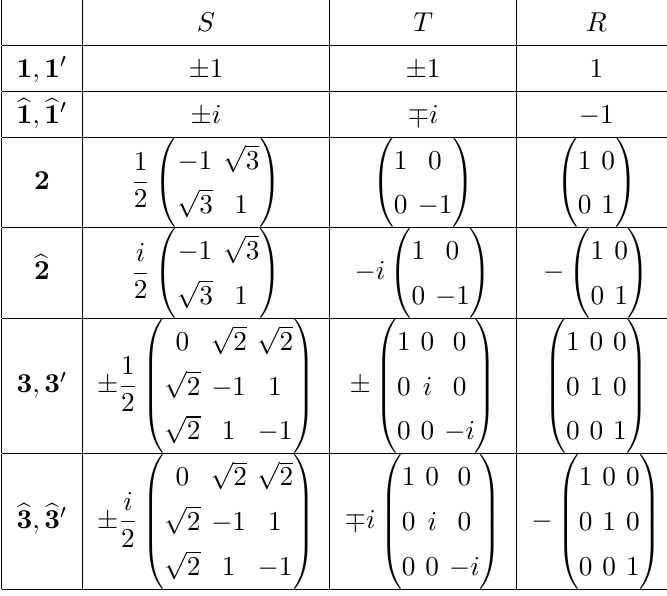
Table 1 . The representation matrices of the generators S, T and R for different irreducible repre- sentations of S 0 in the T -diagonal 4